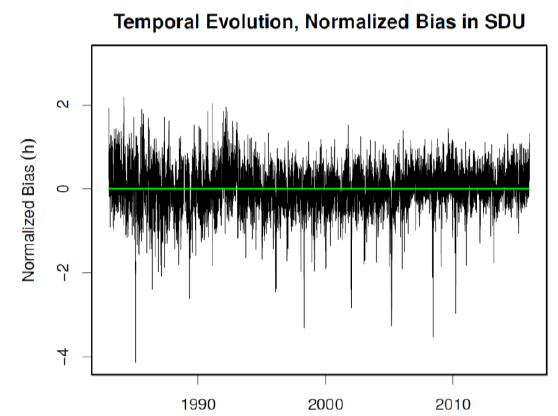
Figure 4. Temporal evolution of the normalized bias (h) between daily SDU and ECA&D for the time period 1983 to 2015. The normalized bias is the mean value for all stations.